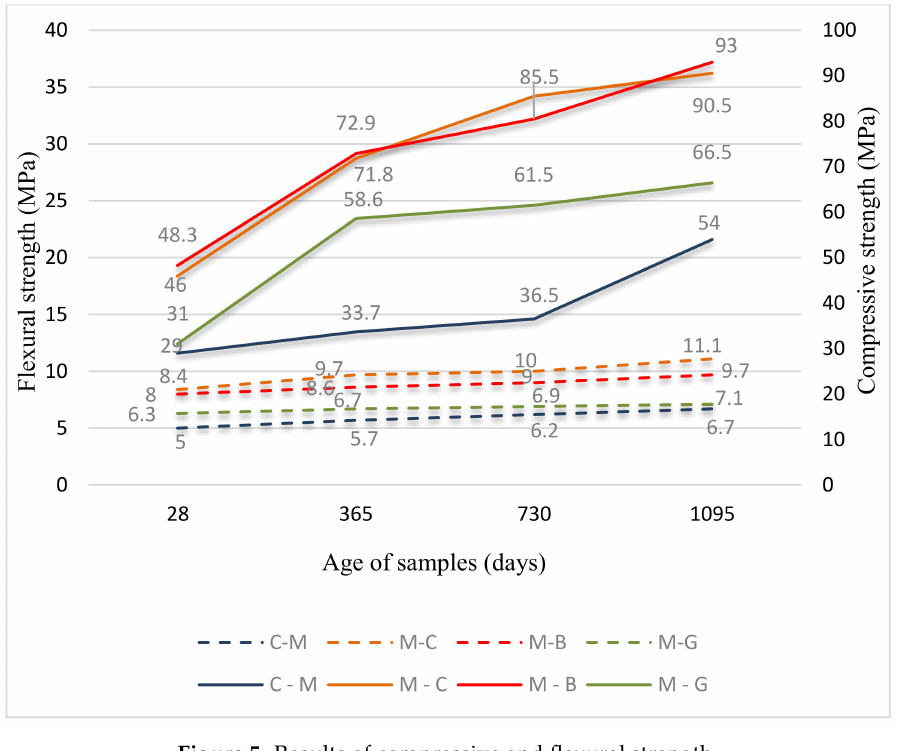
Figure 5. Results of compressive and flexural strength.